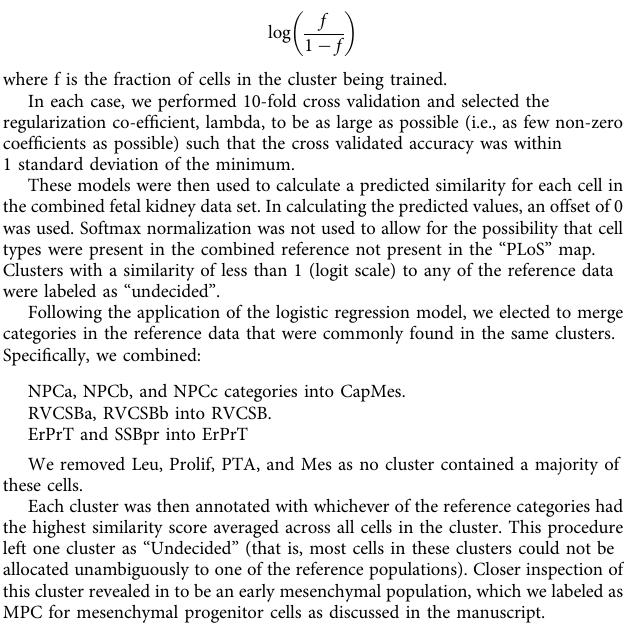
Fig. 6 Adult kidney tumors. A Bulk renal cell carcinomas compared to mature kidney: The relative contribution of single cell derived signals from fetal kidney in explaining the bulk transcriptomes of 171 normal kidney biopsies, 500 clear cell renal cell carcinomas (ccRCC), 274 papillary renal cell carcinomas (pRCC), and 81 chromophobe renal cell carcinomas (ChRCC), along with control populations. The relative contribution of each signal to each bulk RNA-seq sample is shown by the y-axis. Each signal/sample combination is represented by a single point and boxplots shows the distribution with median (middle line), 1 st and 3 rd quartiles (box limits) and 1.5 times the inter-quartile range (whiskers). Each signal type is abbreviated and colored as per the legend, with squares for fetal and circles for mature. B Mast cell fraction in single cell RCC samples: Bar height indicates mast cell fraction (black) or other cell fraction (gray) in 5 single cell RCC expriments (x-axis labels). C Mast cell signals in bulk RCC transcriptomes: Inverse of mast cell fraction for bulk transcriptomes (dots) of type given on x-axis. Boxplots show the distribution median (middle line), 1 st and 3 rd quartiles (box limits), and 1.5 times the inter-quartile range beyond the box-limits (whiskers) and the star indicates that mast cell signals are signi fi cantly higher in pRCC T1 type tumors than pRCC T2 (two-sided Wilcoxon rank-sum test, p = 1.5 × 10 − 5 ). D smFISH validation: An example section of single molecule fl uorescence in-situ hybridization imaging of a pRCC T1 tumor section. Nuclei are stained blue with dapi and expression of the tumor marker MET is shown in green and the mast cell marker TPSB2 in purple. See Supplementary Table 4 for a quanti fi cation of smFISH applied to pRCC T1/T2 and ccRCC tumors. smFISH imaging was performed on one tumor section from each of pRCC T1, pRCC T2, and ccRCC. The scale bar (bottom-right) indicates approximately 100 μ m. E Bulk chromophobe renal cell carcinomas compared to mature kidney: The same as A , but for 81 chromophobe renal cell carcinomas (ChRCC) bulk transcriptomes. Source data are available as a Source Data fi